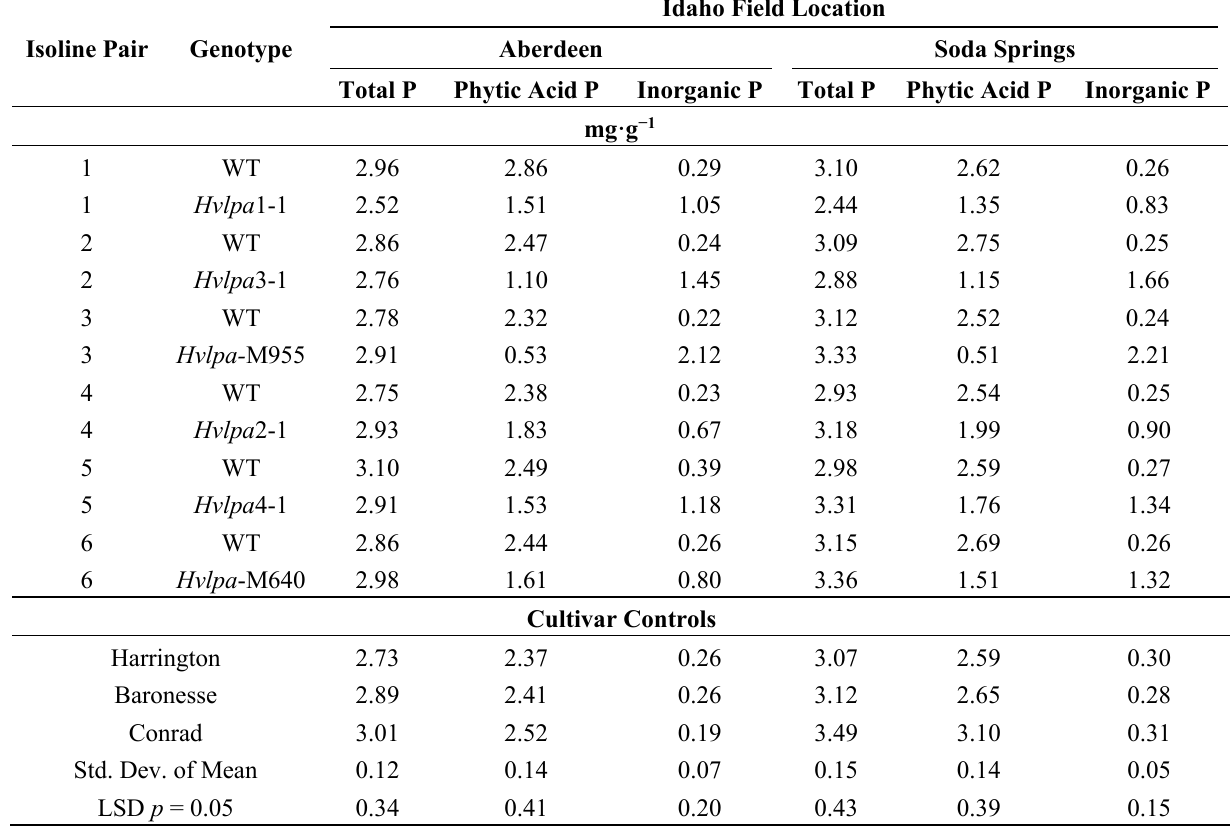
Table 1. Seed total phosphorus (Total P), phytic acid P and inorganic P (P i ) in pairs of sibling barley near-isogenic and cultivar controls grown in Aberdeen and Soda Springs, ID, in 2011. Isoline Pair Genotype